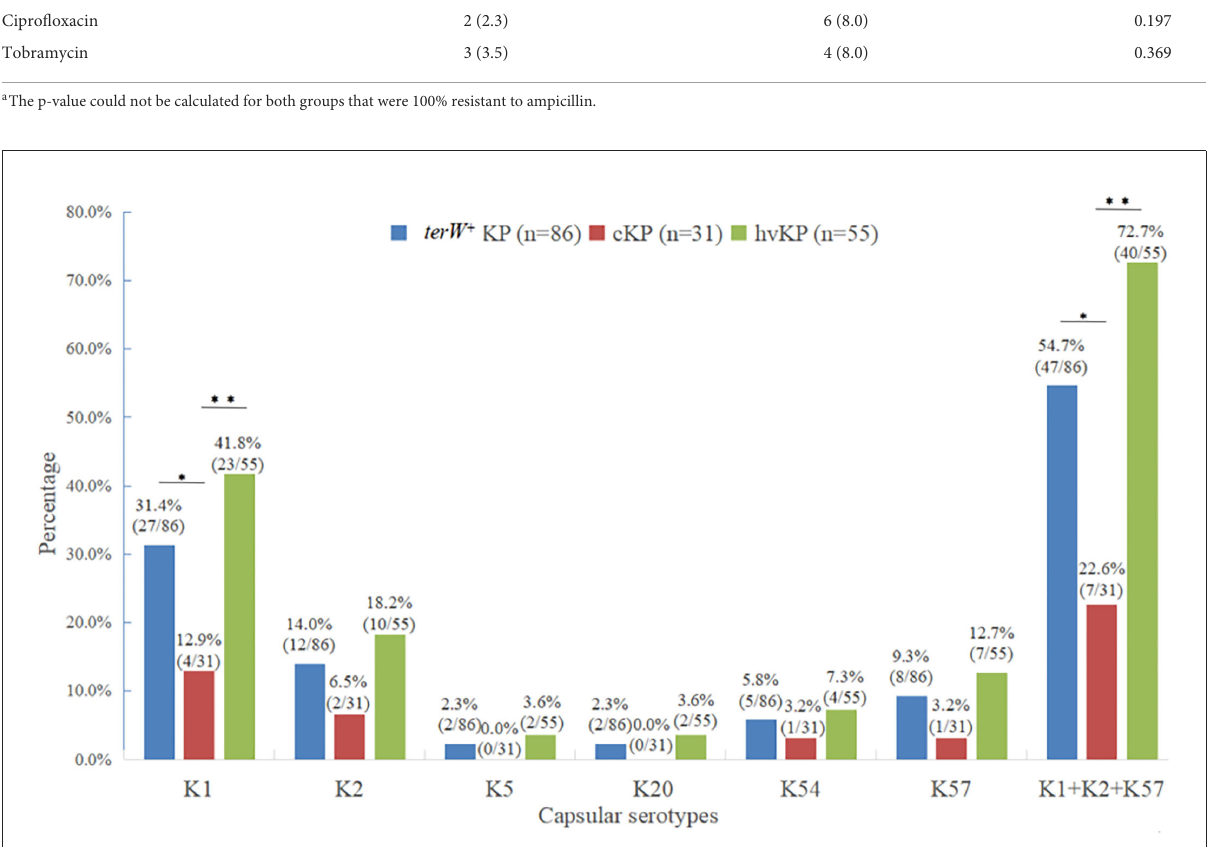
FIGURE1 Distribution of major virulent capsular serotypes of terW + KP isolated from feces of healthy volunteers by MCKT medium (* P < 0.05, ** P < 0.01, no asterisk: P >